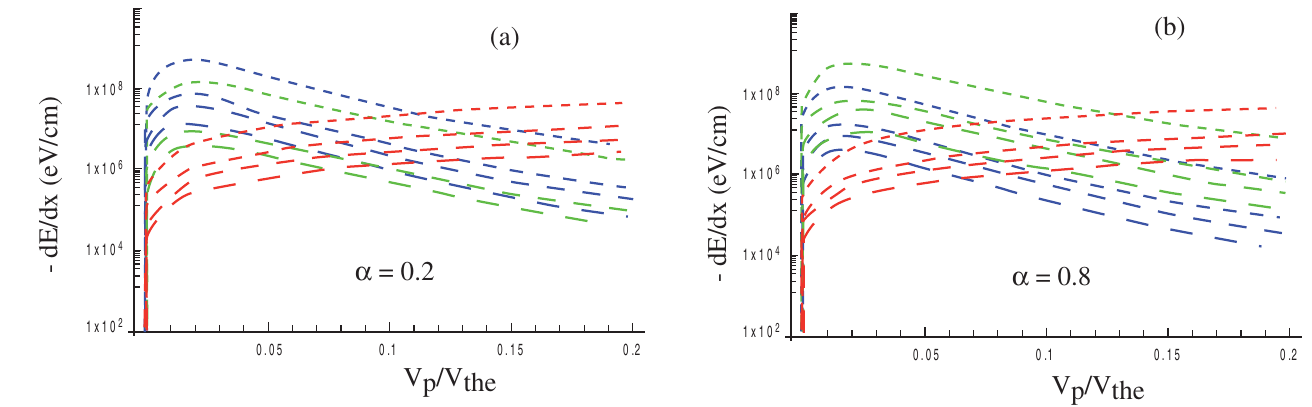
FIG. 1. (Color) Proton particle projectile in a deuterium-tritium BIM with n e ¼ 10 23 e - cm (cid:1) 3 and temperatures ¼ ( ) 100 eV, ) 2 keV, and ( ) 5 keV with D þ relative proportion: (a) (cid:1) ¼ 0 : 2 and (b) (cid:1) ¼ 0 : 8 . Dark gray (red) refers to electron stopping, light gray (green) to D þ stopping, and black (blue) denotes T þ stopping, (cid:1) dE=dx ( eV = cm ) in terms of V p =V the .